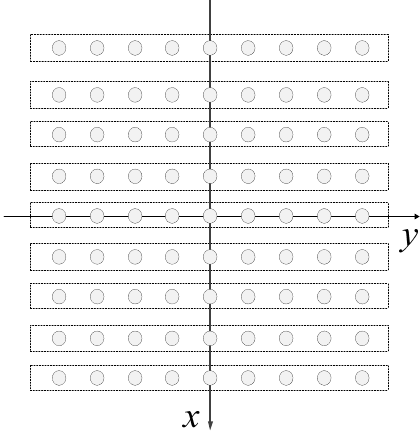
Figure 3. Virtual array form Mills Cross array in Figure 2.